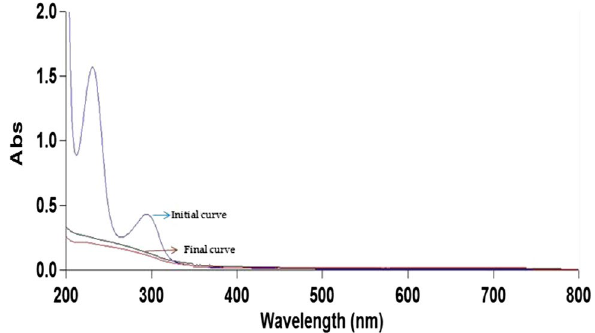
Fig. 3 Initial and final scan of p -anisidine at pH 2.5. ( Source : UV– Vis